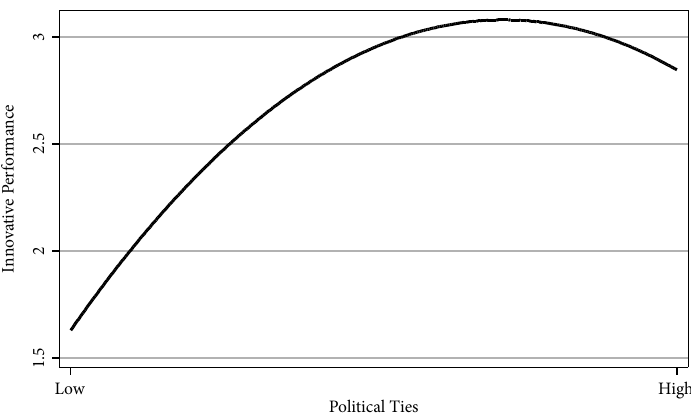
Figure 1. The inverted-U relationship between politic ties and corporate innovation performance